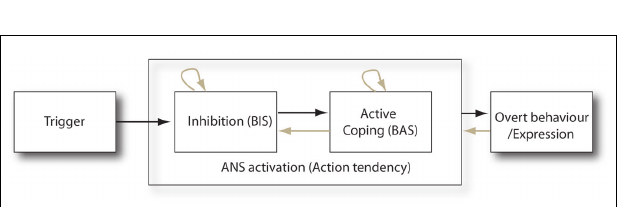
FIGURE 3 |The relation between action tendency and action. The gray arrows superimpose a dynamic perspective onto an otherwise conventional feed-forward model of emotional behavior. Only the “dynamic” model is in line with the motivation-grounded perspective.